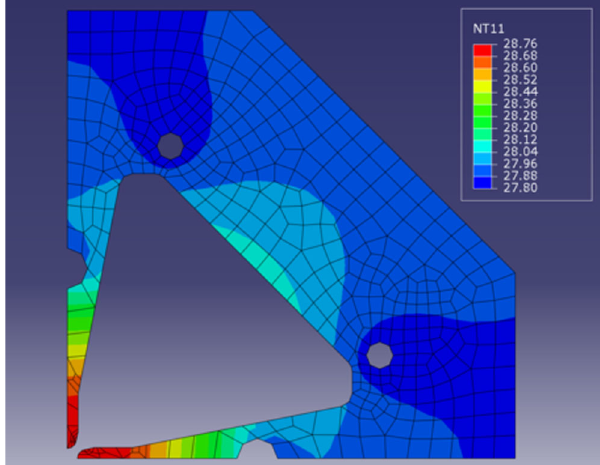
FIG. 8. Temperature distribution calculated with ABAQUS . The water temperatures of both the vane and wall channels are 27 : 2 (cid:1) C . NT11 denotes the temperature at each node.